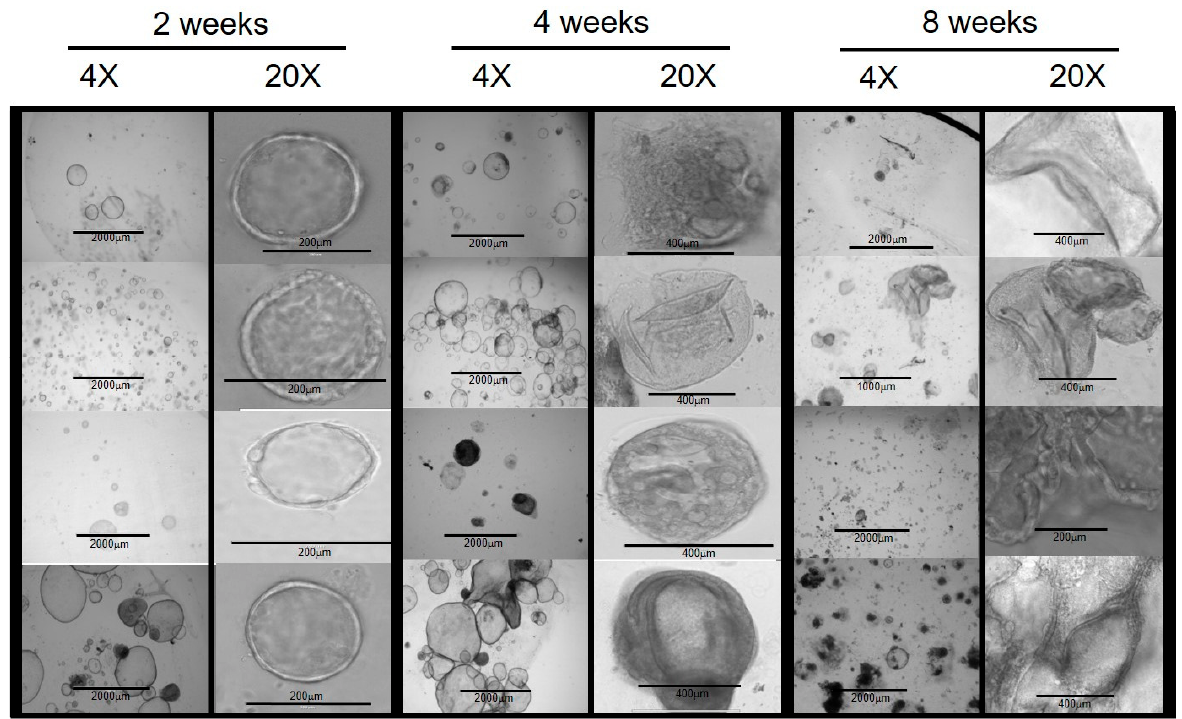
Figure 1. Chol-org morphology over 8 weeks from 4 different patient samples with underlying liver disease (from top to bottom: PFICIII, autoimmune hepatitis, alpha-1 antitrypsin deficiency, and ornithine transcarbamylase deficiency). At 2 weeks, chol-orgs demonstrate a simple spheroidal shape which develops into multi-layered and complex structure by 8 weeks.